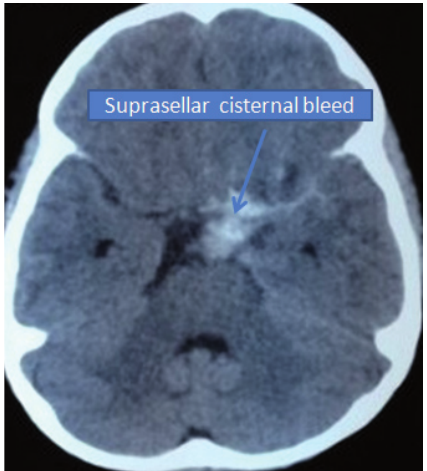
Figure 1. Initial CT scan showing the region of the bleed.